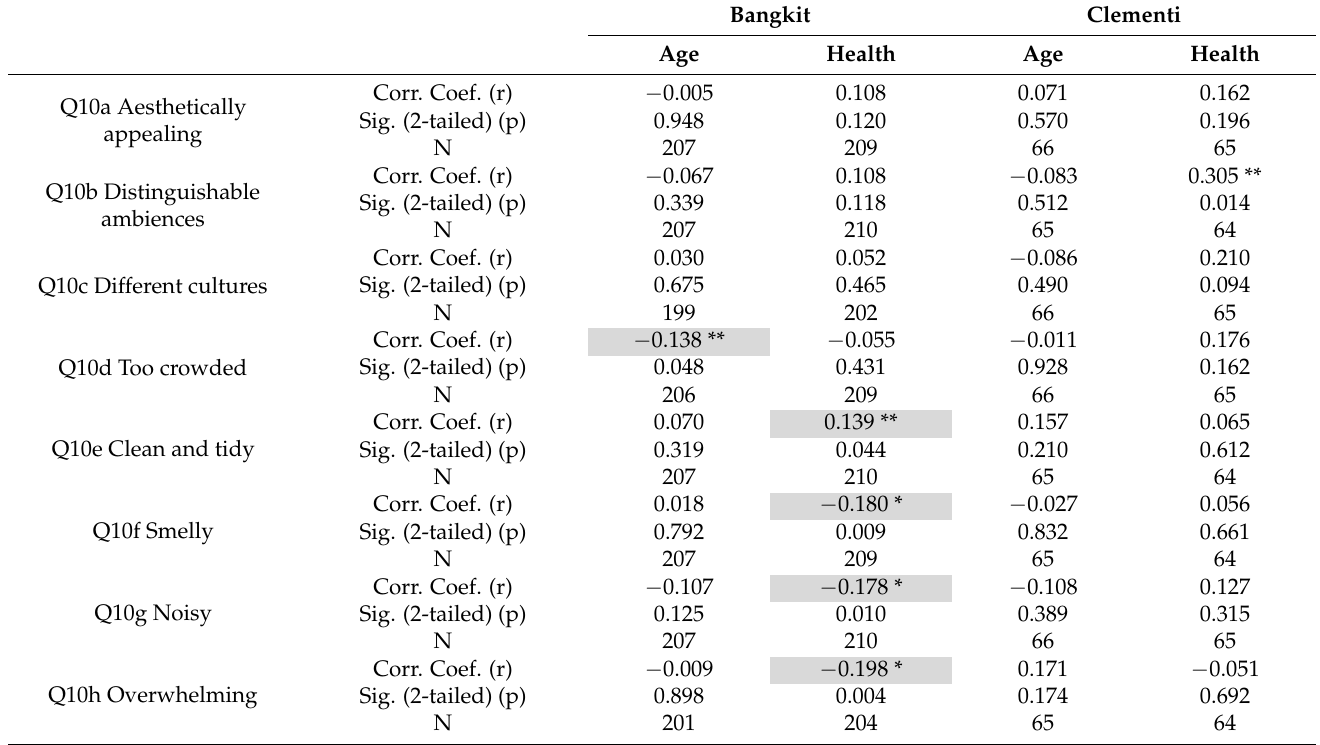
Table 10. Spearman correlation test: correlation between sensory appreciation (Question 10 of Socio-sensory Survey, Appendix A), age and health